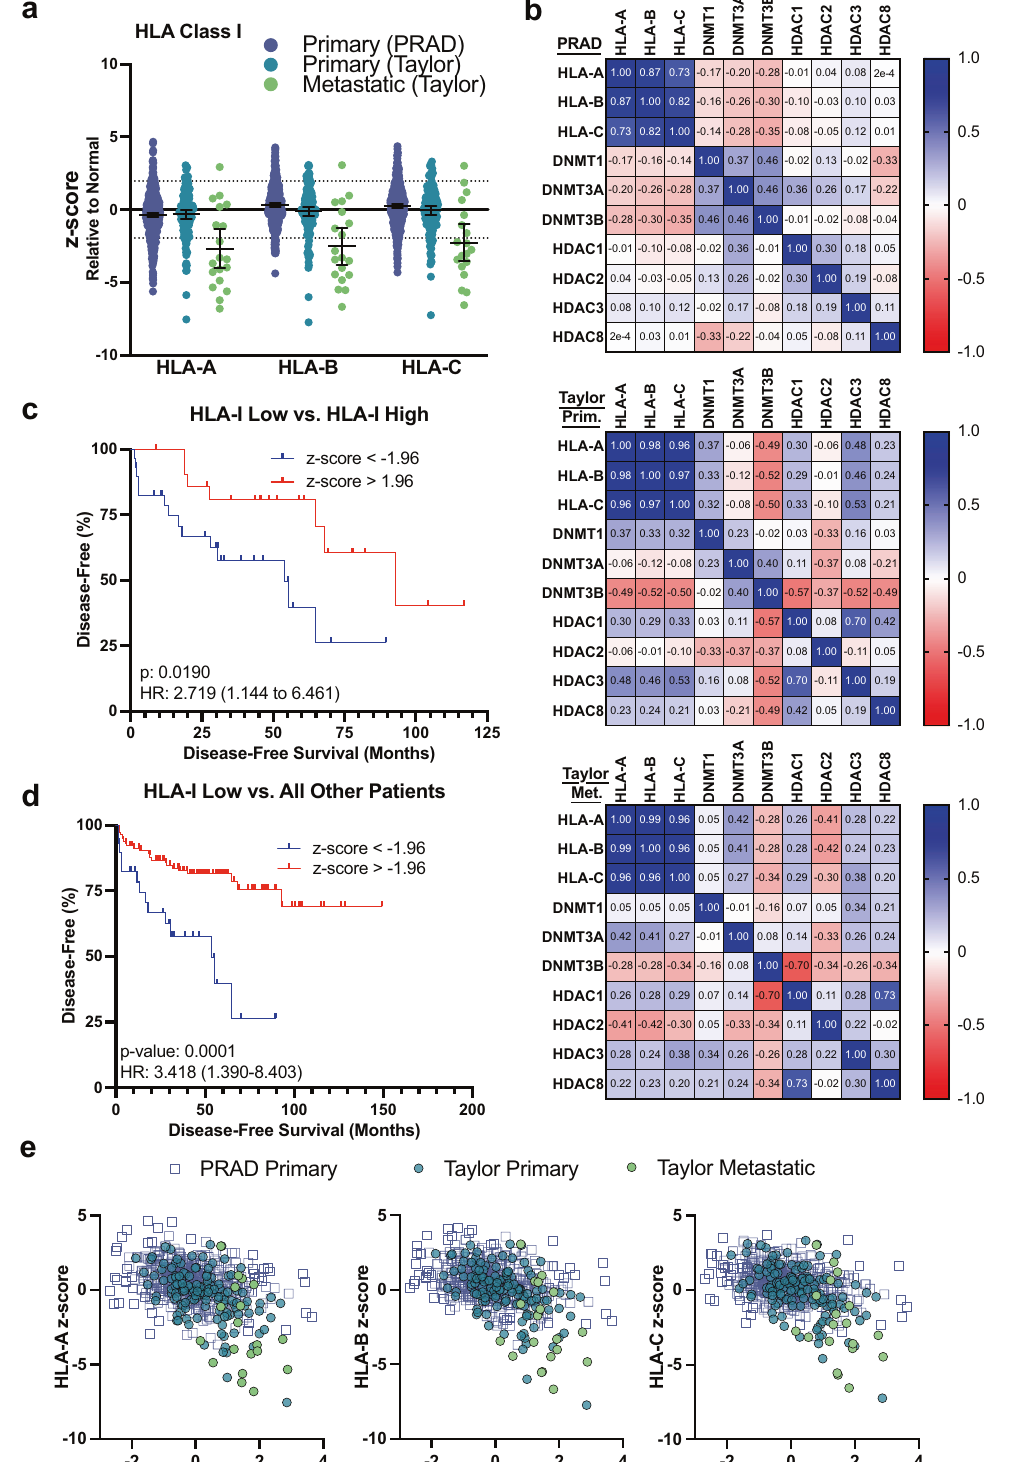
Fig. 1 Genomic alterations and gene expression of HLA-I in primary and metastatic prostate adenocarcinoma. a HLA-A, HLA-B, and HLA-C gene expression in the TCGA-PRAD data set (PRAD, n = 497, blue circle), and Taylor data set (Primary n = 131, teal circle; Metastatic n = 19, green circle) represented as z-scores relative to normal samples in the respective study. Dotted lines are at + / − 1.96. Line and error bars represent mean and 95% con fi dence interval. b Correlation matrix of gene expression of HLA-I genes and epigenetic modifying proteins in PRAD data set. c Kaplan – Meier curves showing disease-free survival time for patients in the Taylor data set with low expression (z-score < − 1.96; n = 29) vs. high expression (z-score >1.96, n = 22) of any HLA-I gene. d Kaplan – Meier curves showing disease-free survival time for patients in the Taylor data set with low HLA-I expression in any HLA-I gene (z-score < − 1.96, n = 29) vs. all other patients (z-score > − 1.96, n = 116). e Correlation of expression of DNMT3b to HLA-I